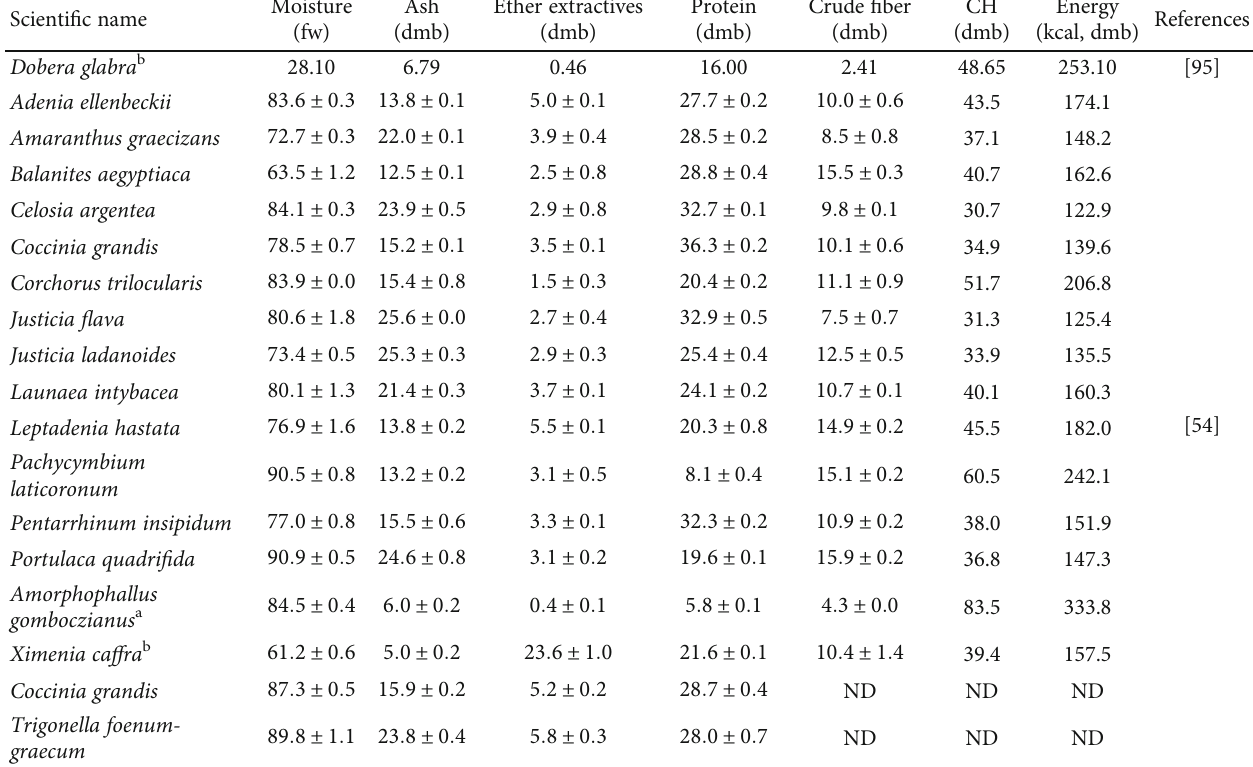
Table 1: Proximate composition (g/100 g) of some selected wild edible plants.